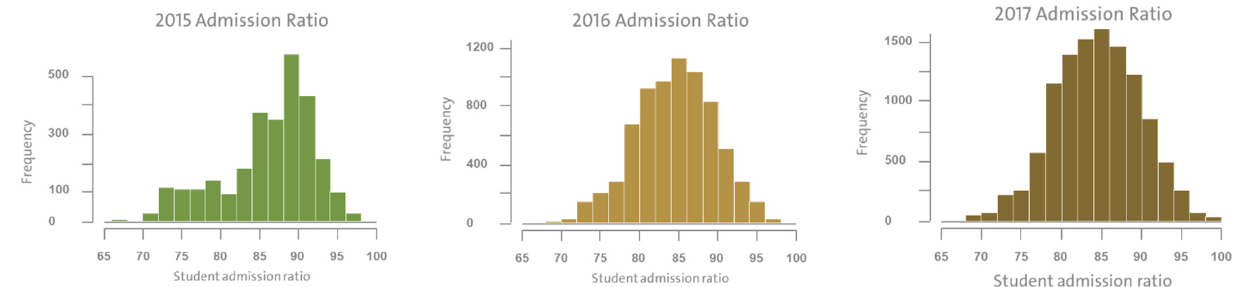
Figure 2. The admission ratio of the students for the three years.